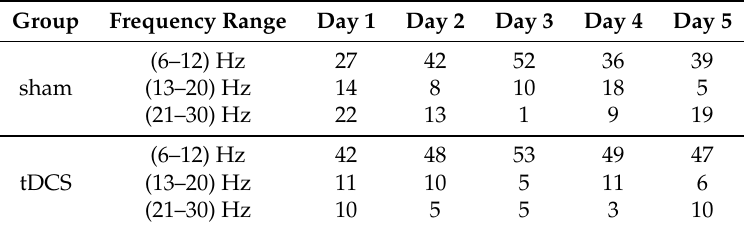
Table 5. Optimal frequencies histogram for each day and group.